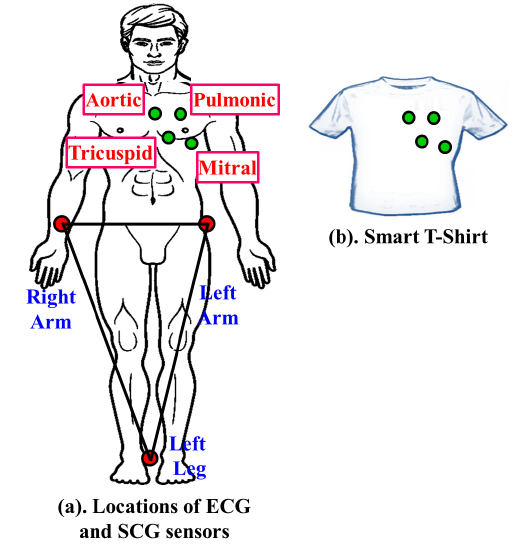
Figure 2. Locations of ECG/SCG sensors for data